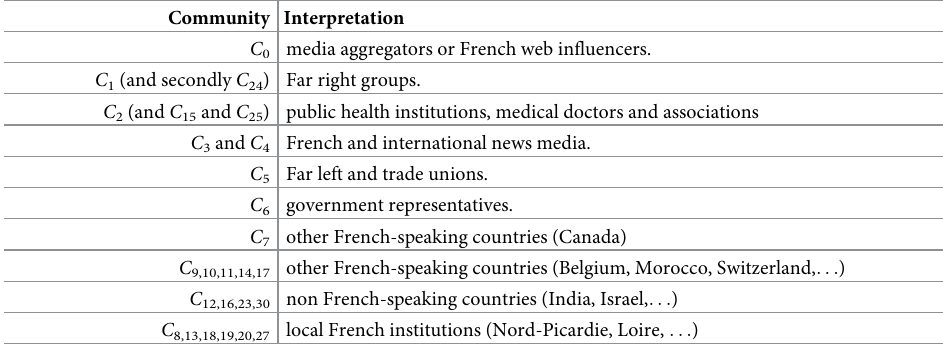
Table 2. Communities and their respective qualitative